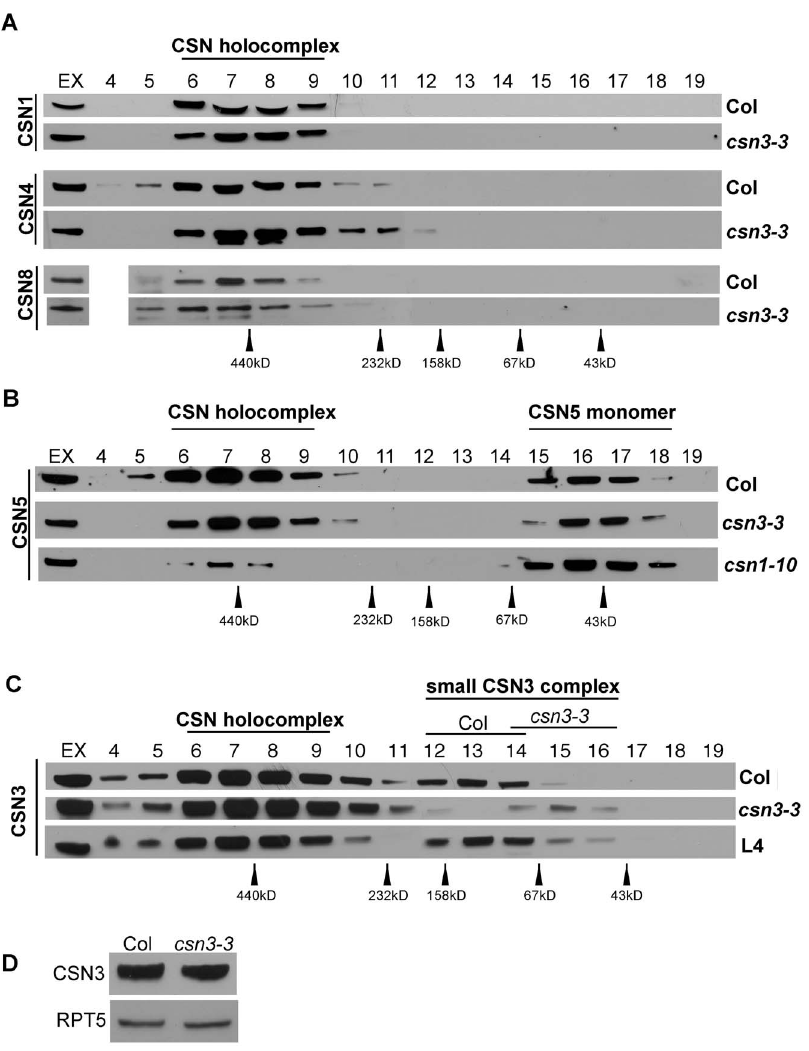
Figure 6. A small CSN3-containing complex, but not the CSN, is affected by the csn3-3 mutation. Protein extracts from 7-d.o. Col, csn1-10 and csn3-3 seedlings were fractionated on a Superdex-200 gel filtration column and fractions (4 to 19) were collected and blotted with a -CSN1, a - CSN4, and a -CSN8 ( A ), a -CSN5 ( B ) and a -CSN3 ( C ). Fraction # 4 was lost in the experiment examining CSN8. In ( C ), the assembly of a small CSN3- containing protein complex was observed in fractions 12-14. This complex was absent in csn3-3 extracts, but was restored by introduction of a genomic CSN3 transgene (L4 complementation line). Molecular mass standards are shown at the bottom of each panel. EX indicates the protein crude extract before gel filtration. ( D ) CSN3 protein level is unaffected by the csn3-3 mutation. RPT5 is shown as a loading